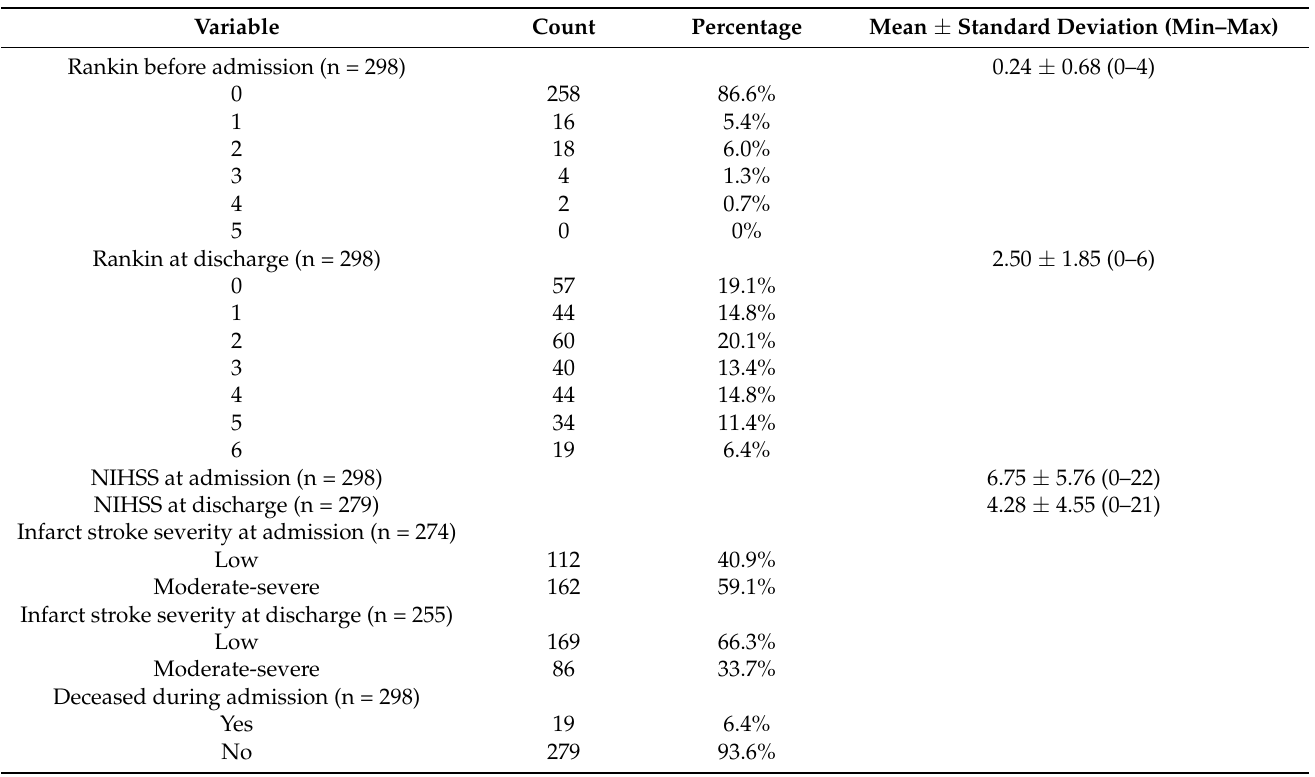
Table 3. Functional and disability patients’